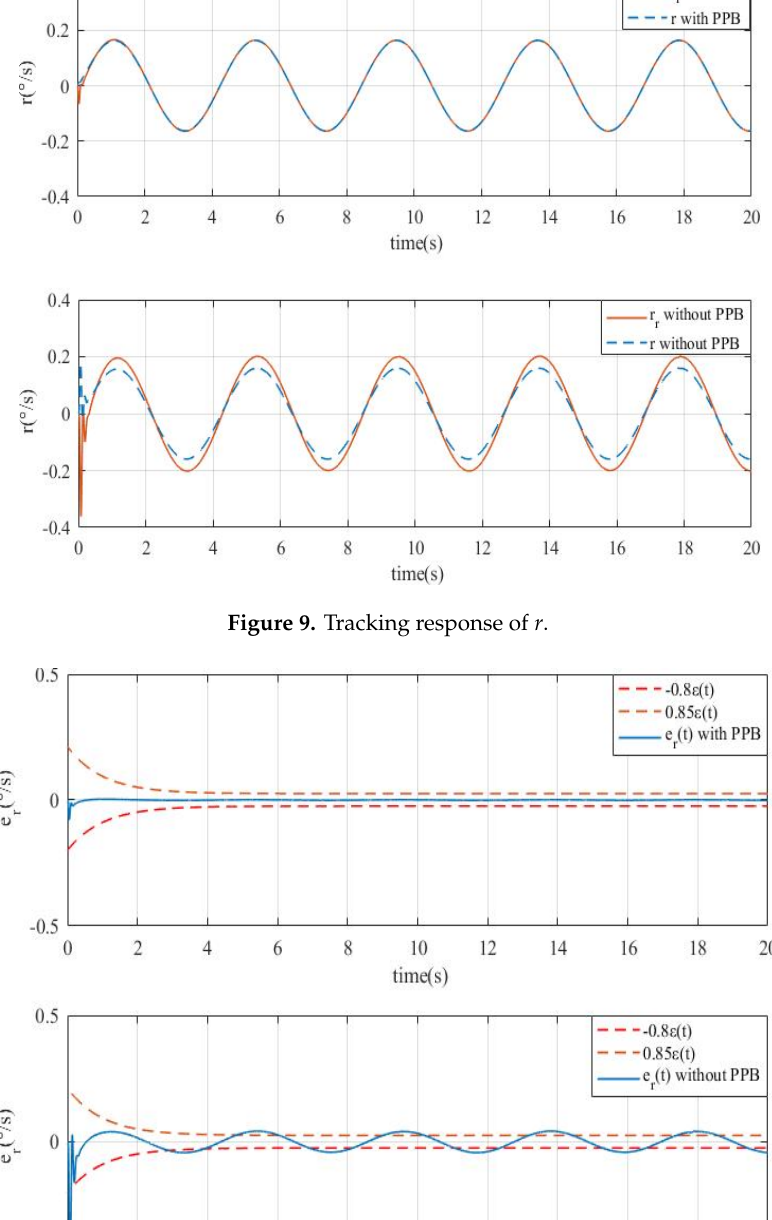
Figure 8. Tracking response of q .